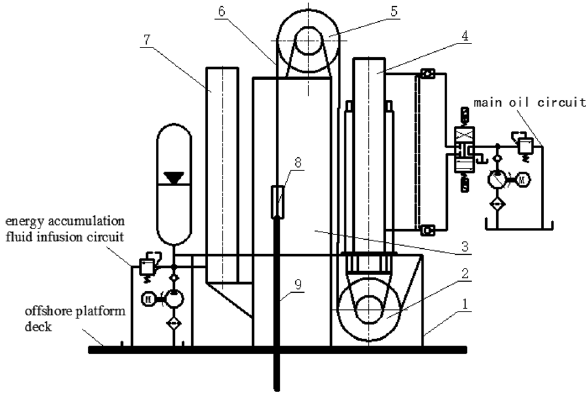
Fig. 2 Schematic diagram of offshore hydraulic pumping unit whole structure ( 1 -base, 2 -driving pulley, 3 -frame, 4 -combined cylinder, 5 - crown sheave, 6 -elevating belt, 7 -accumulator cylinder, 8 -beam hanger, 9 -polished